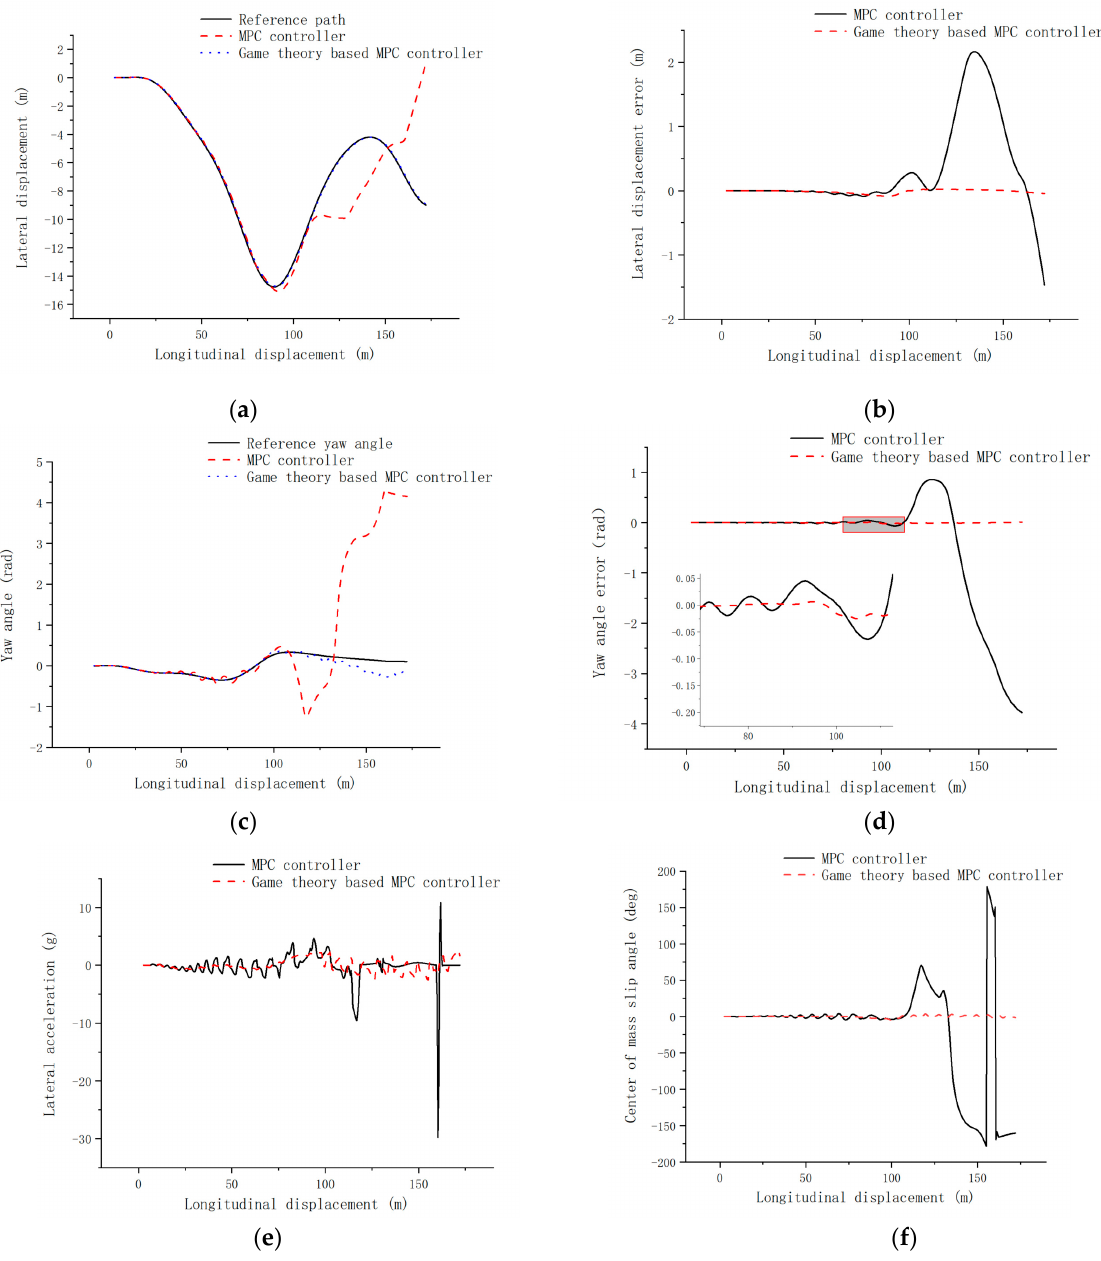
Figure 7. Simulation comparison of the two controllers at a speed of 90 km/h. ( a ) Comparative diagram of lateral displacement; ( b ) comparative diagram of lateral error; ( c ) comparative diagram of yaw; ( d ) comparative diagram of yaw angle error; ( e ) comparative diagram of lateral acceleration; ( f ) comparative diagram of center of mass slip angle.